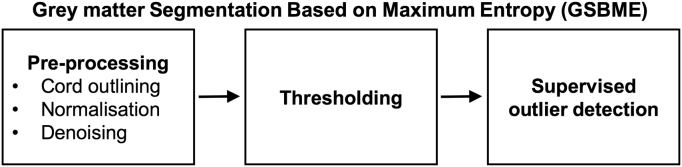
Block diagram describing the three-stage GSBME procedure for grey matter segmentation in anatomical MRI data of the spinal cord. The first step of the procedure is pre-processing, which implements whole-cord segmentation, signal intensity normalisation and image denoising. The second step is the thresholding of the sum of grey/white matter signal intensity entropies. The final stage consists of a one-class classifier for supervised outlier detection.